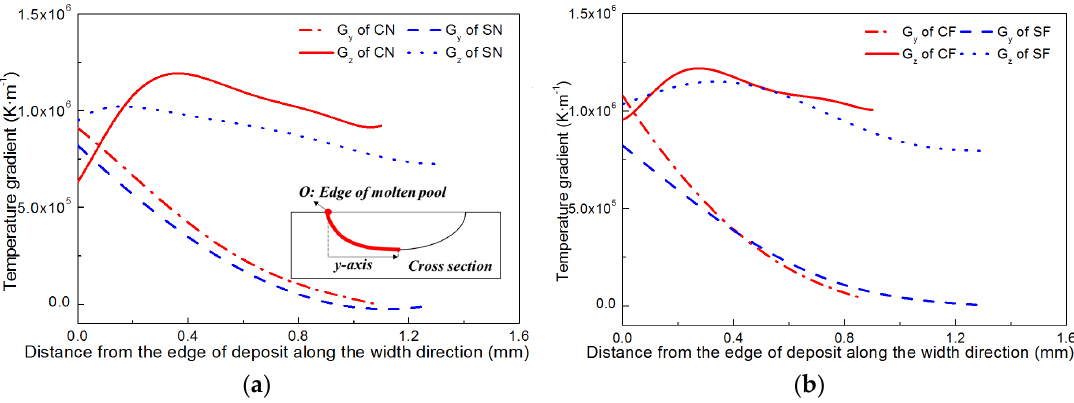
Figure 11. Temperature gradients in front of the solid–liquid interfaces in cross-sections. ( a ) under natural cooling conditions; ( b ) under forced cooling conditions.